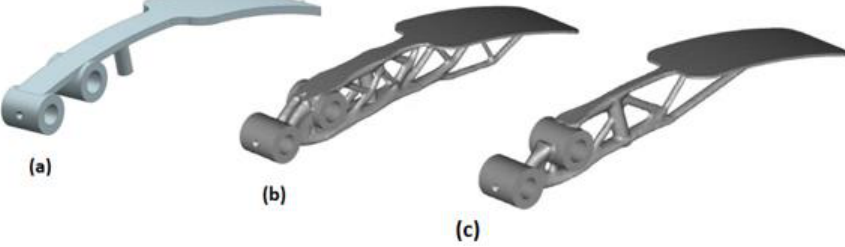
Figure 2. ( a ) Original design. ( b ) Optimised design 1. ( c ) Optimised design 3, reproduced from [60], with the permission from Inderscience, 2018.